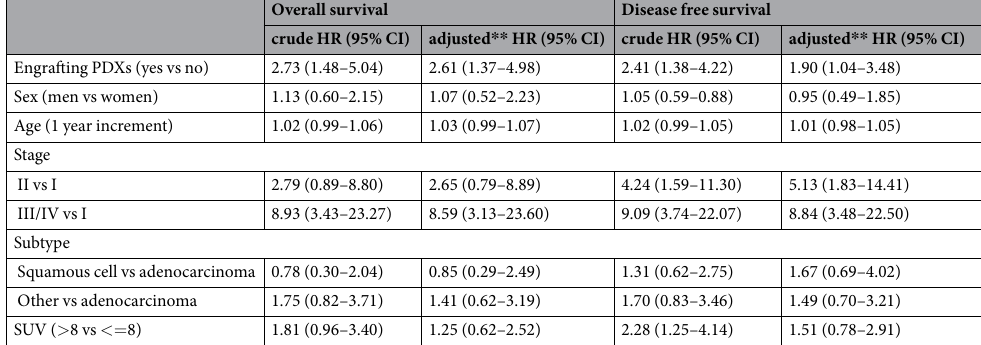
Table 2. Hazard ratios (HR) and 95% confidence intervals of overall survival and disease free survival according to tumour graft, age, sex, stage and SUV. ** Estimated from Cox proportional hazard regression model adjusted for engrafting PDXs, sex, age, tumour stage, tumour subtype, and